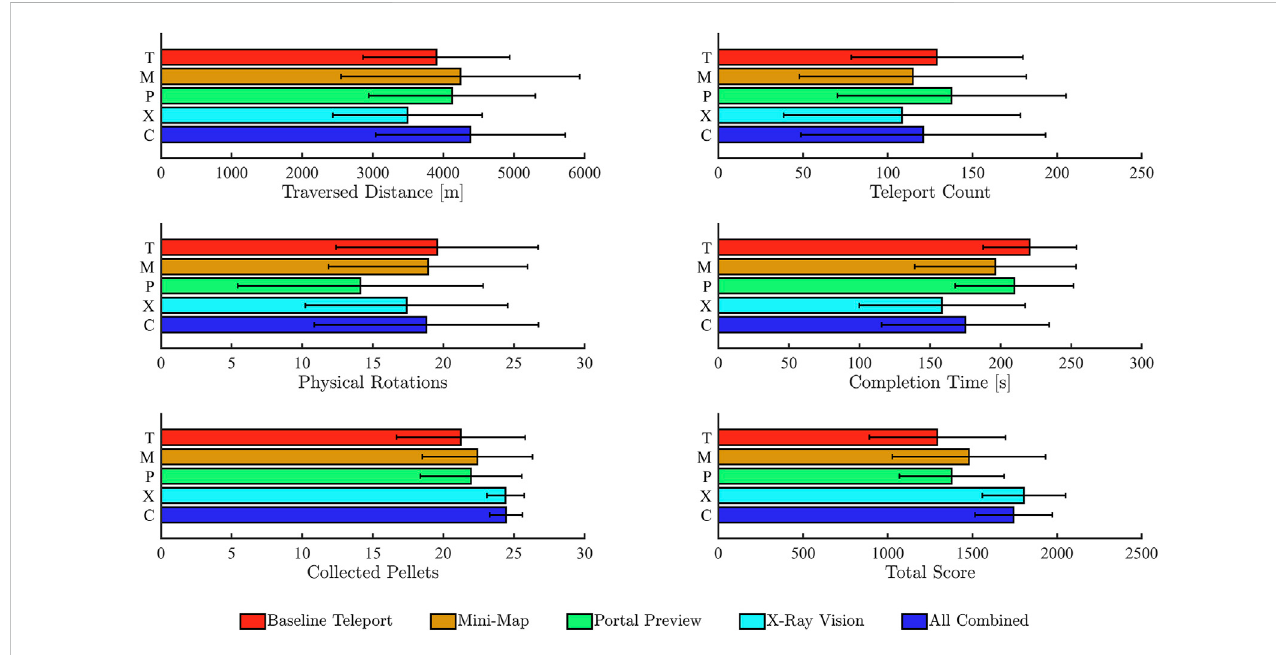
FIGURE 7 The average value of different objective metrics along with standard deviation